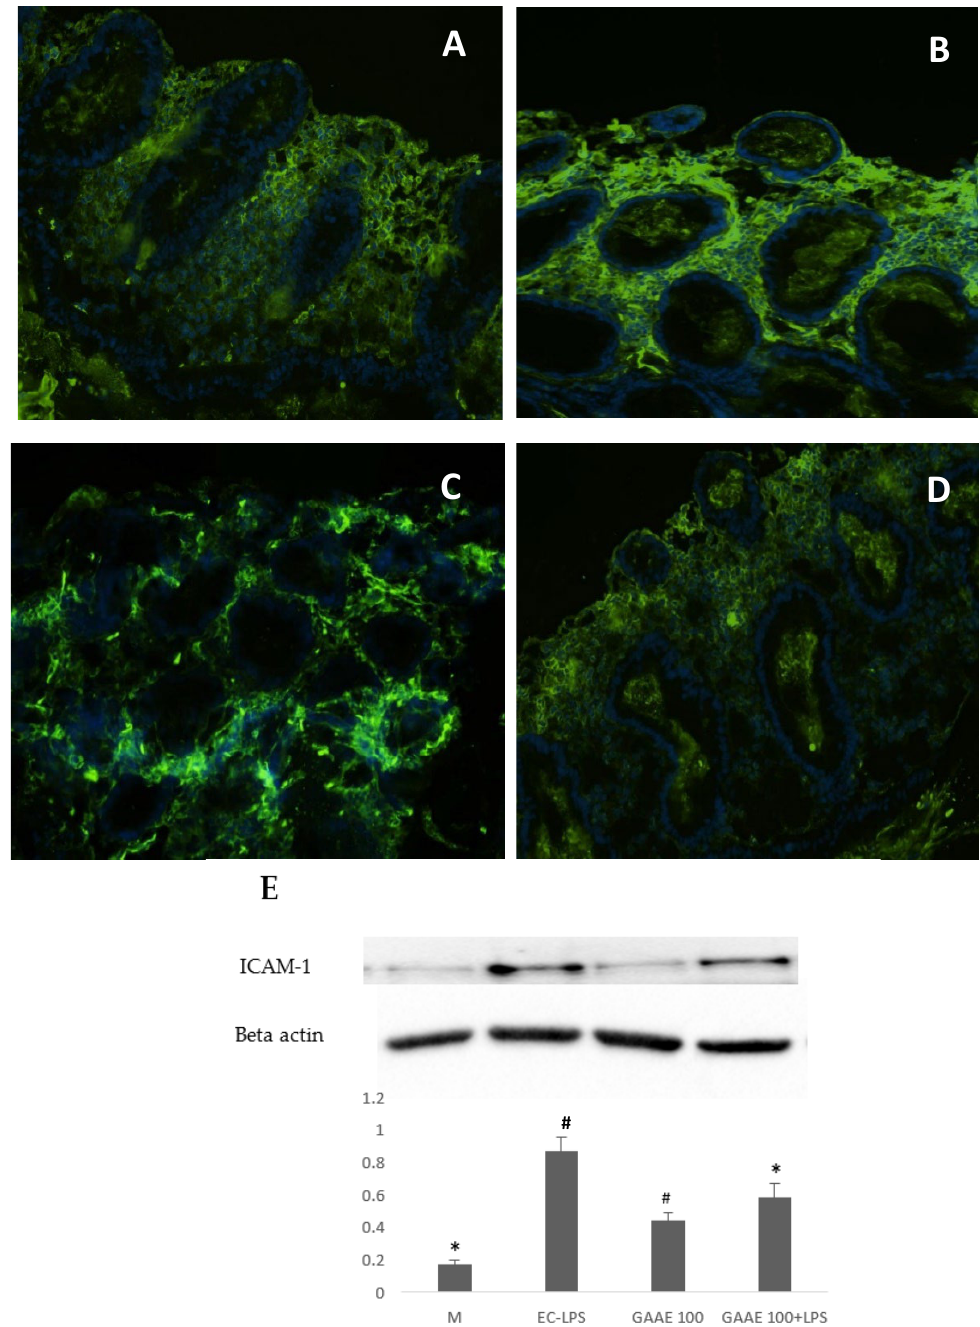
Figure 9. GAAE pre-treatment effect on ICAM-1 expression in UC patient biopsies challenged with EC-LPS. ( A ) No treated biopsy; ( B ) biopsy challenged with 1 µ g/mL EC-LPS; ( C ) biopsy treated with 100 µ g/mL GAAE; ( D ) biopsy cotreated with 100 µ g/mL GAAE and 1 µ g/mL EC-LPS; ( E ) Western blotting with the same treatments. Results are expressed as means ± S.E.M. ( N = 31), * p < 0.05 vs. EC-LPS, # p < 0.05 vs. medium (Student’s t - test).